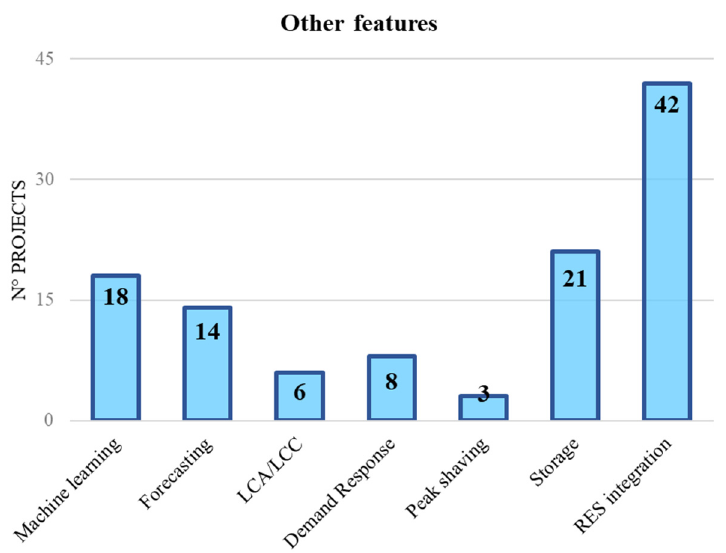
Figure 8. Number of projects per other features included in the project activities. The detailed explanation of the features is reported in Table 1.